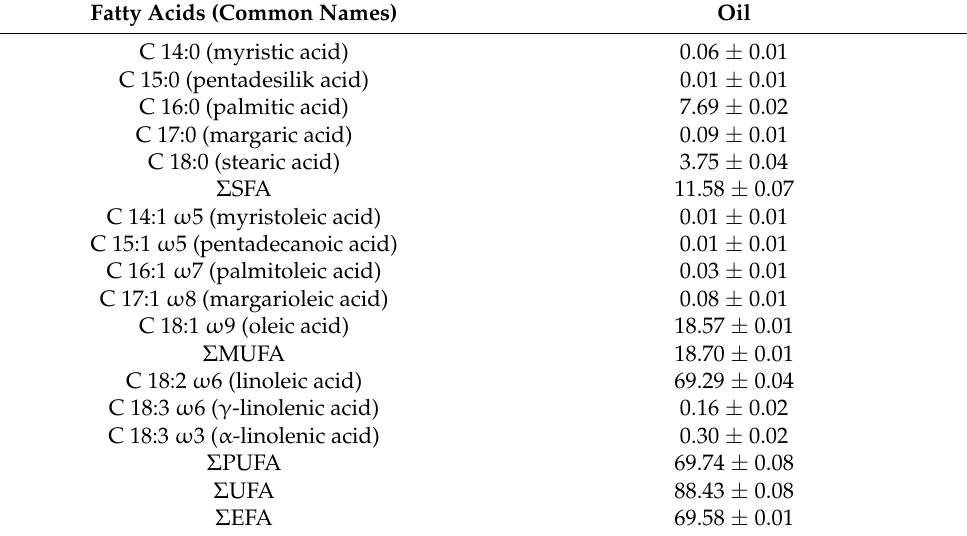
Table 3. Fatty acid composition of grape seed oil